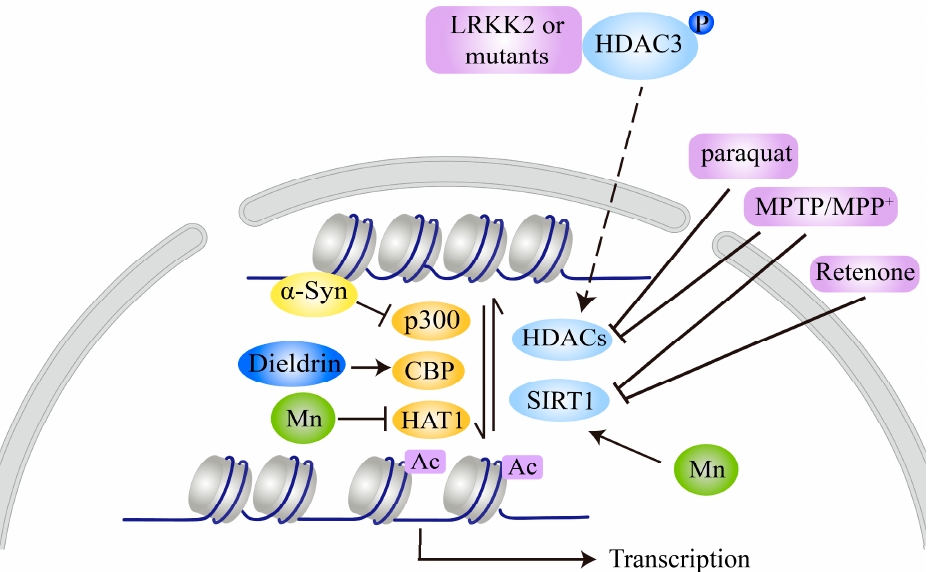
Figure 2. Lysine acetylation of histones mediated by PD-related neurotoxins and genetic factors. MPTP / MPP + , rotenone, paraquat, or dieldrin treatment leads to hyperacetylation of H3 and / or H4 by decreasing the activity or expression of certain HDACs or SIRT1 or by increasing CBP expression. α -syn causes hypoacetylation of H3 by binding to histones or inhibiting p300 expression and activity. LRKK2 or its mutants repress H4 acetylation by phosphorylating HDAC3 and promoting its nuclear translocation to increase its activity. Mn decreases H3 and H4 acetylation by increasing HDAC3 / 4 expression and decreasing HAT1 expression, respectively.